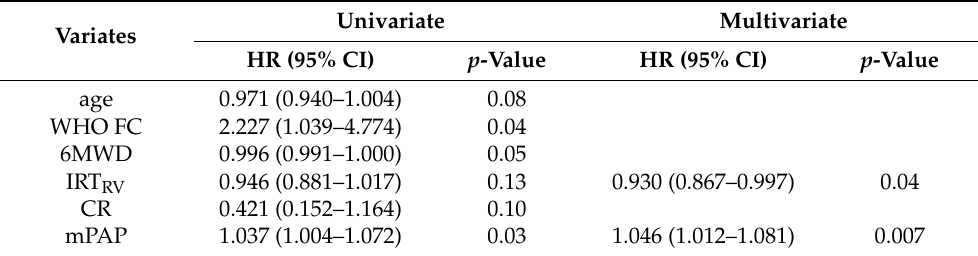
Table 7. Univariable and multivariable Cox proportional hazard analysis for the